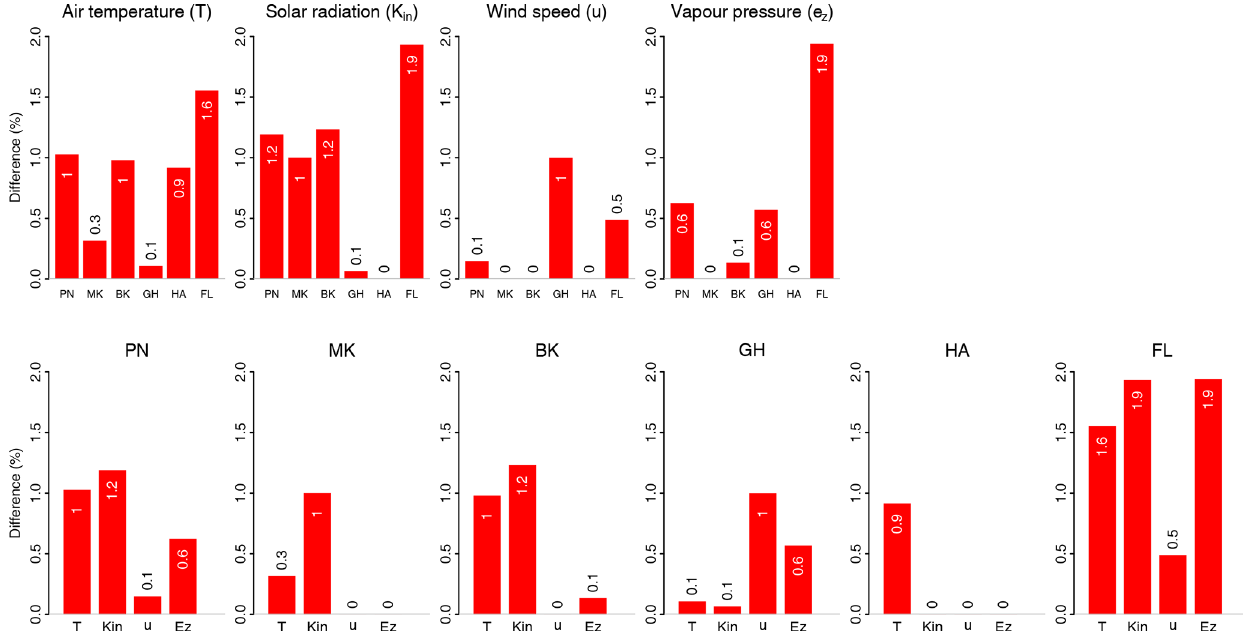
Figure 7. Sensitivity of simulated evaporation to meteorological drivers. This effect is expressed as the percentual difference between a perturbed simulation and the baseline as indicated by the white numbers plotted in the bars (rounded to one decimal). Upper set of panels arranged per variable. The lower set of panels displays the same information but clustered per method. Table 3. Water losses through evaporation for the Lake IJssel region under different conditions. Water losses are expressed as water depths in